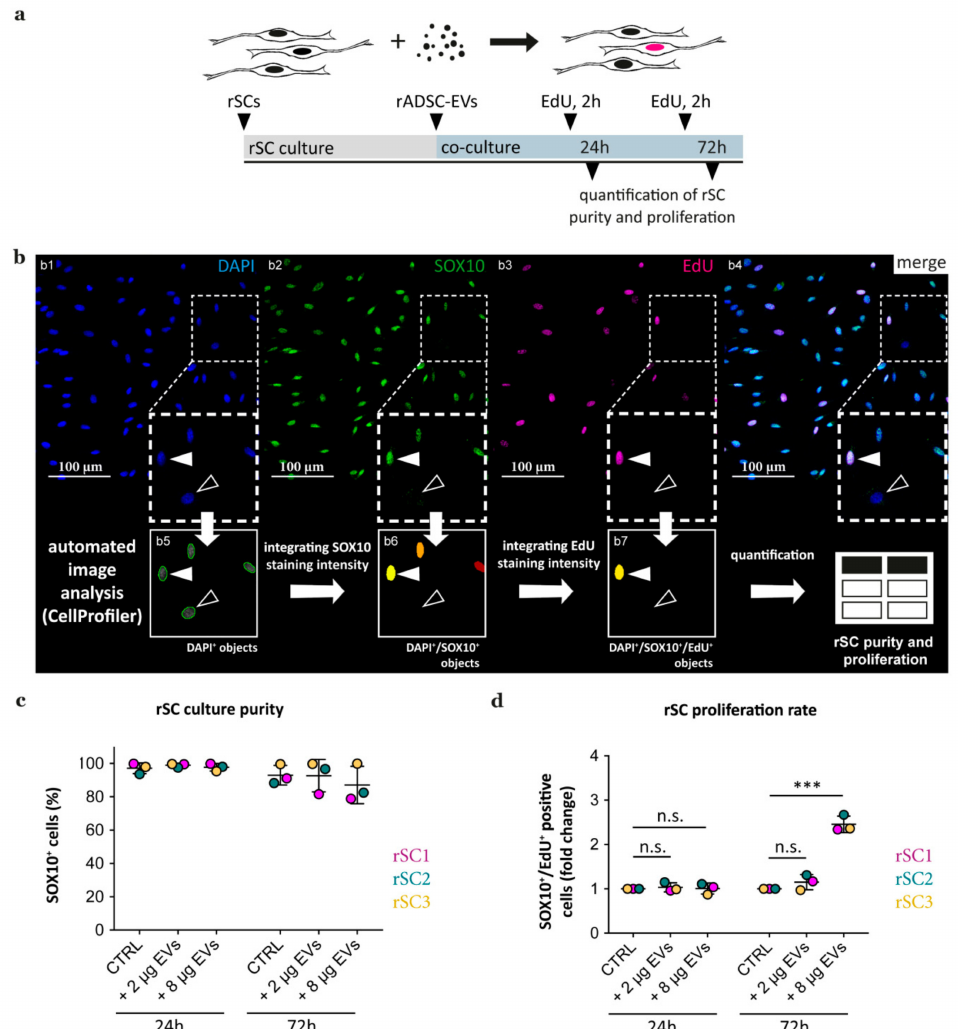
Figure 4. Quantification of rat Schwann cell (rSC) purity and proliferation in response to rADSC-EVs. ( a ) Set up of the proliferation experiment. ( b ) Immunofluorescence staining of rSCs stained for DAPI ( b1